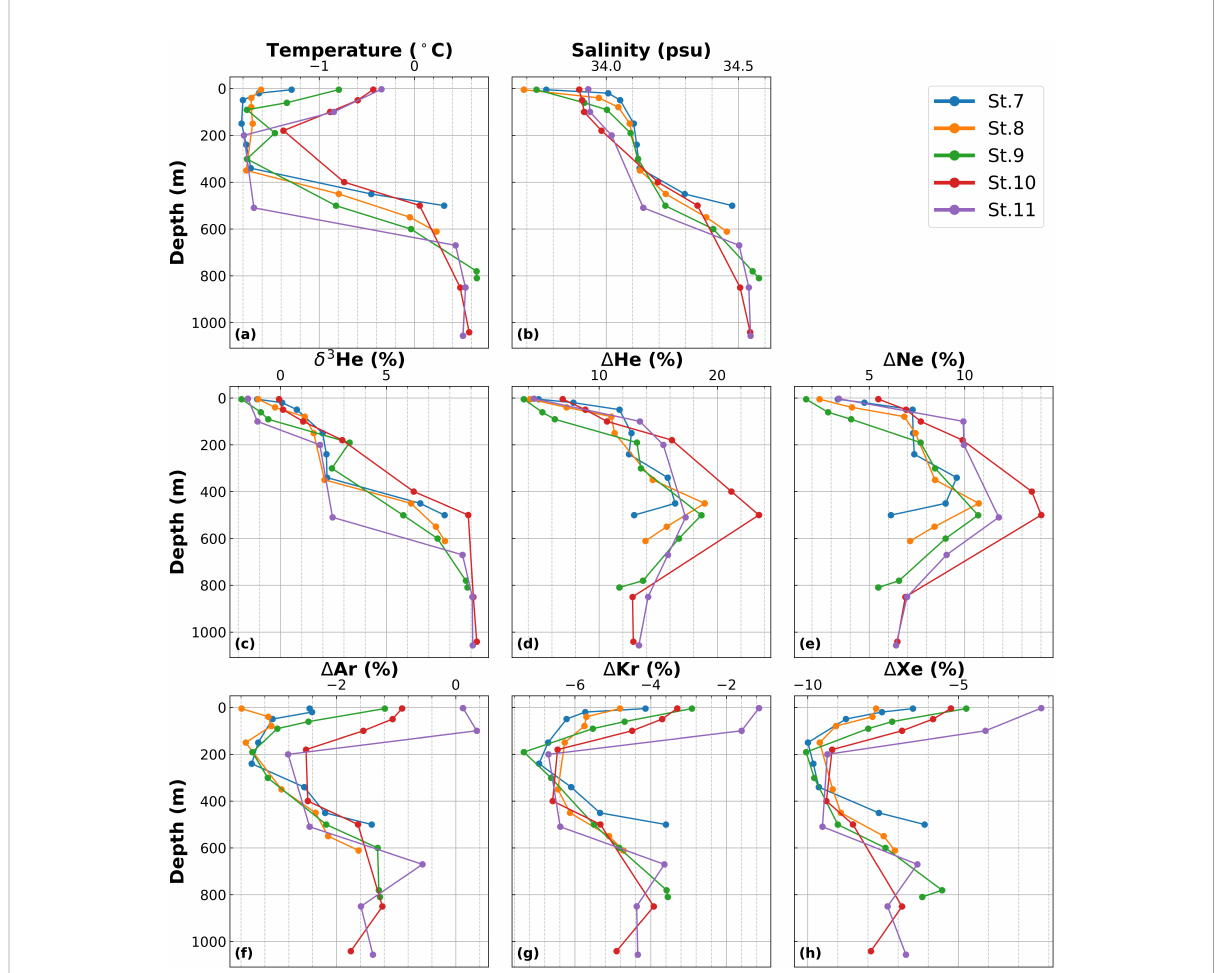
FIGURE 2 Vertical pro fi les of the tracers used for the NG-OMPA. (A) Potential temperature, (B) salinity, and (C) isotopic ratio of helium de fi ned as d 3 He = [( 3 He/ 4 He) sample /R A - 1]× 100,where ( 3 He/ 4 He) sample is the measured ratio of a sample and R A is the isotopic ratio of the atmosphere. (D − H) Saturation anomalies of the noble gases, de fi ned as (C sample /C sat - 1)100, where C sample and C sat are the measured and solubility equilibrium concentrations,